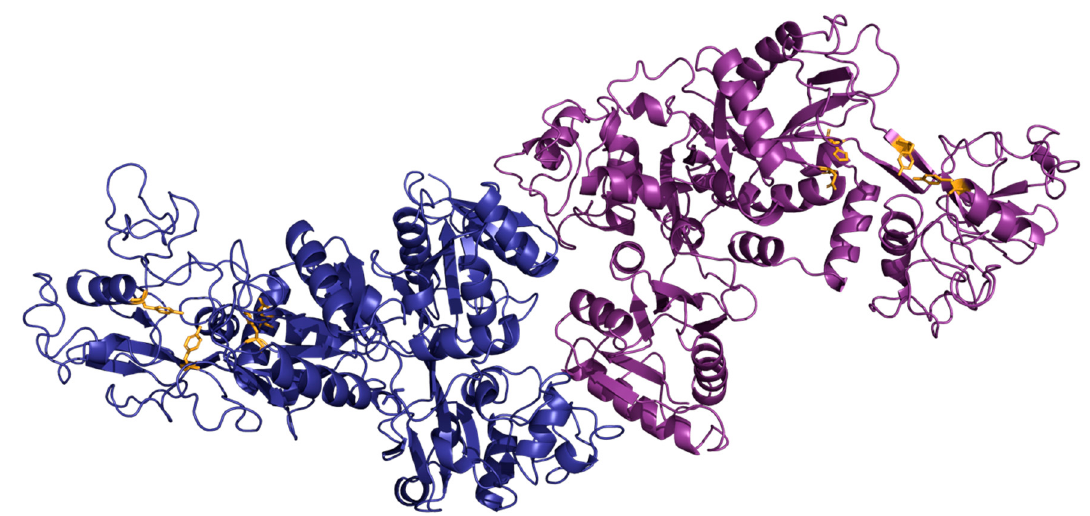
Figure 6. It shows the crystal structure of apo-transferrin; crystals diffracted up to 2.9 Å at the best temperature, keeping the optimal pH and appropriate cryo-protection conditions as described in the experimental part.